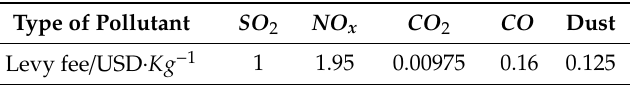
Table 2. Penalty for pollutant